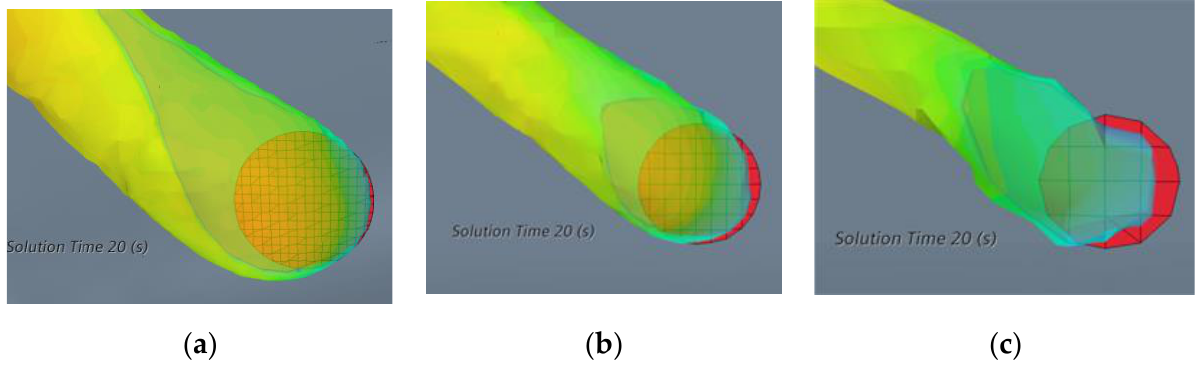
Figure 5. The numerical loss of the computational domains under different mesh numbers: ( a ) 100+ complete meshes; ( b ) 25+ complete meshes; ( c ) 4+ complete meshes.